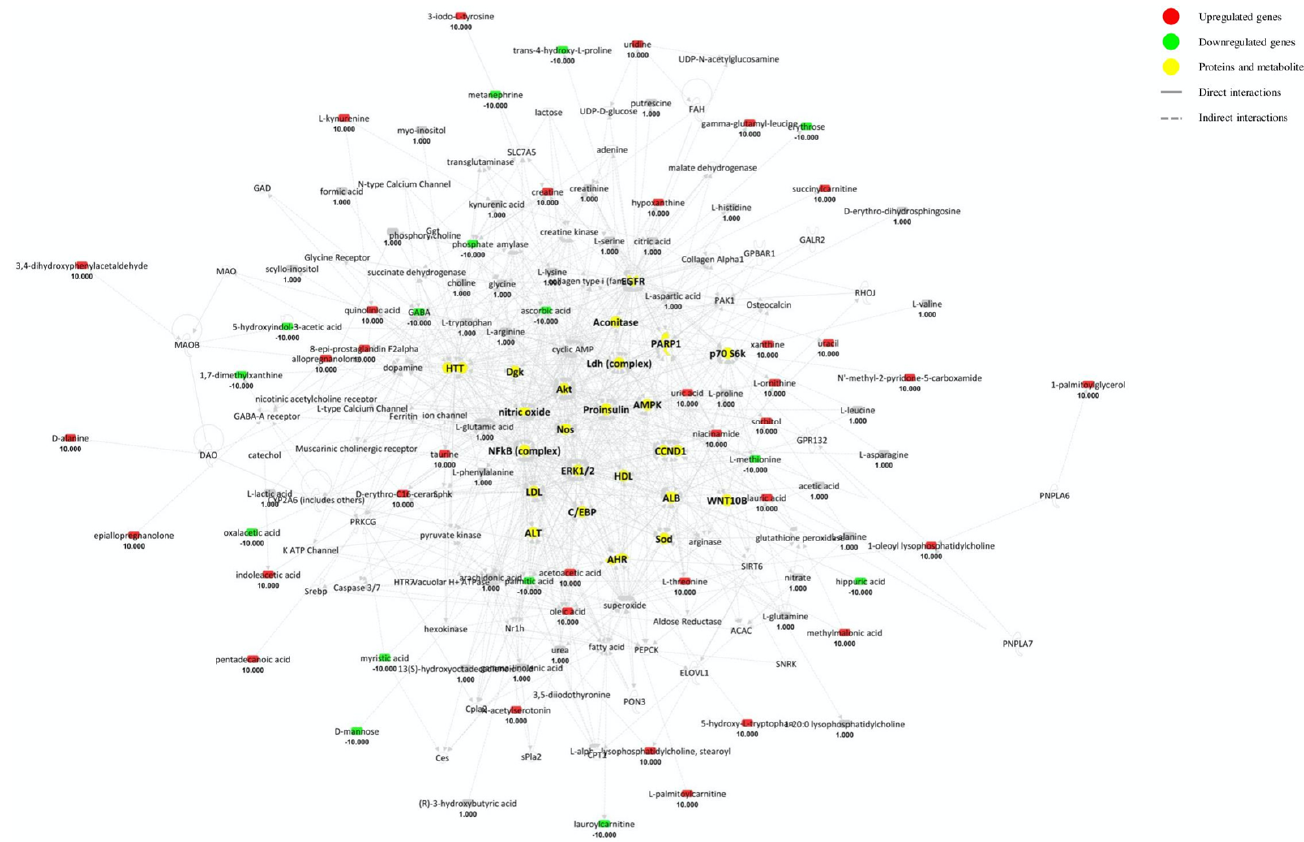
Figure 2. Merged networks based on inter-metabolite connections from the total matrix. Red and green shapes indicate genes significantly increased or decreased in expression in MS patients, whereas the number below represents the fold change log. The relationship between genes may lead to direct (solid lines) or indirect interaction (dashed lines). Yellow shapes indicate proteins and metabolites from the total matrix.